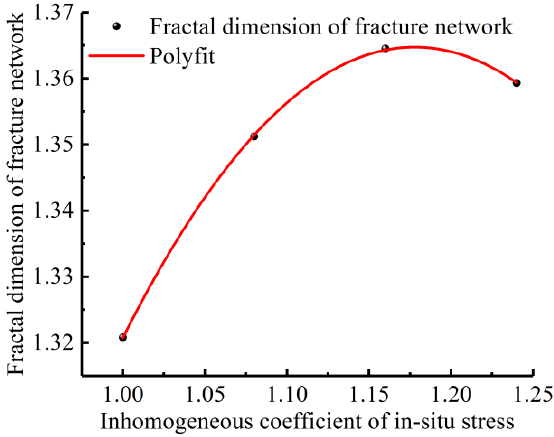
Figure 21. Variation curve of the fractal dimension of segmental hydraulic fractures in CBM reservoirs under various values of the inhomogeneity coefficient of the in situ stress.